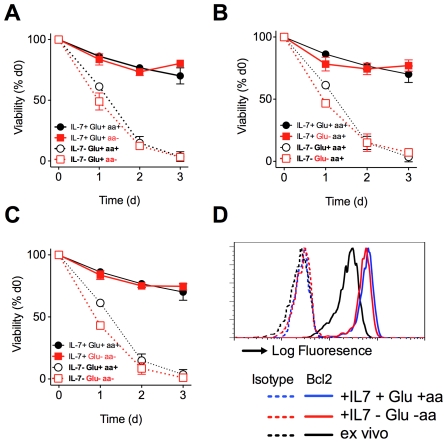
Neither amino acids nor glucose are required for IL-7 dependent survival of naïve CD8 T cells.CD8+ T cells were enriched from C57Bl/6J donors and cultured for the indicated time points, either alone (open symbols, dashed lines), or in the presence of 50 ng/ml of IL-7 (filled symbols, solid lines). Cultured cells were stained with 7AAD and frequency of viable 7AAD− cells amongst total CD44lo CD8+ T cells determined by flow cytometry. Cells were cultured in RPMI medium containing standard nutrients (circles) or in RPMI specifically lacking (A) amino acids (aa−), (B) glucose (Glu−) or (C) glucose and amino acids (Glu− aa−, squares throughout). (D) CD8+ T cells from C57Bl6/J donors were cultured for 24 h in the presence of 50 ng/ml of IL-7, in RPMI either containing standard nutrients (+Glu +aa) or in the absence of glucose and amino acids (−Glu −aa). Cells were stained for Bcl-2 and expression compared with ex vivo CD44loCD8+ T cells. Histograms show Bcl2 expression by CD44lo CD8+ T cells cultured in the presence (blue solid line) and absence (red solid line) of glu and aa, as compared with ex vivo CD44lo CD8+ T cells (black solid line). Broken lines indicate isotype negative control stainings for each population. (A–C) Error bars indicate SD of technical replicates. Results are representative of three experiments.